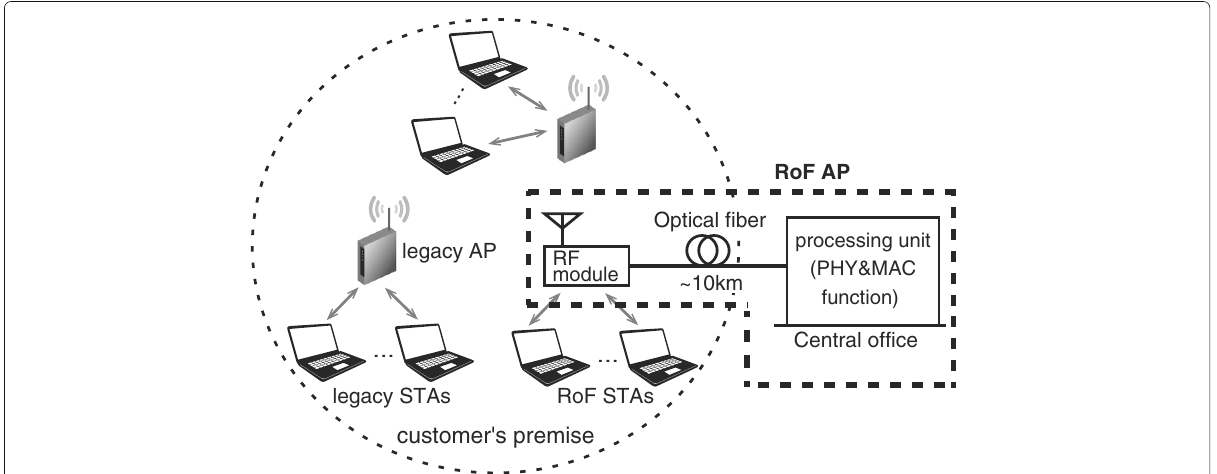
Fig. 1 Coexistence of RoF-based WLAN and legacy WLANs. Legacy APs and STAs, RoF STAs, and RF unit of RoF AP are deployed densely